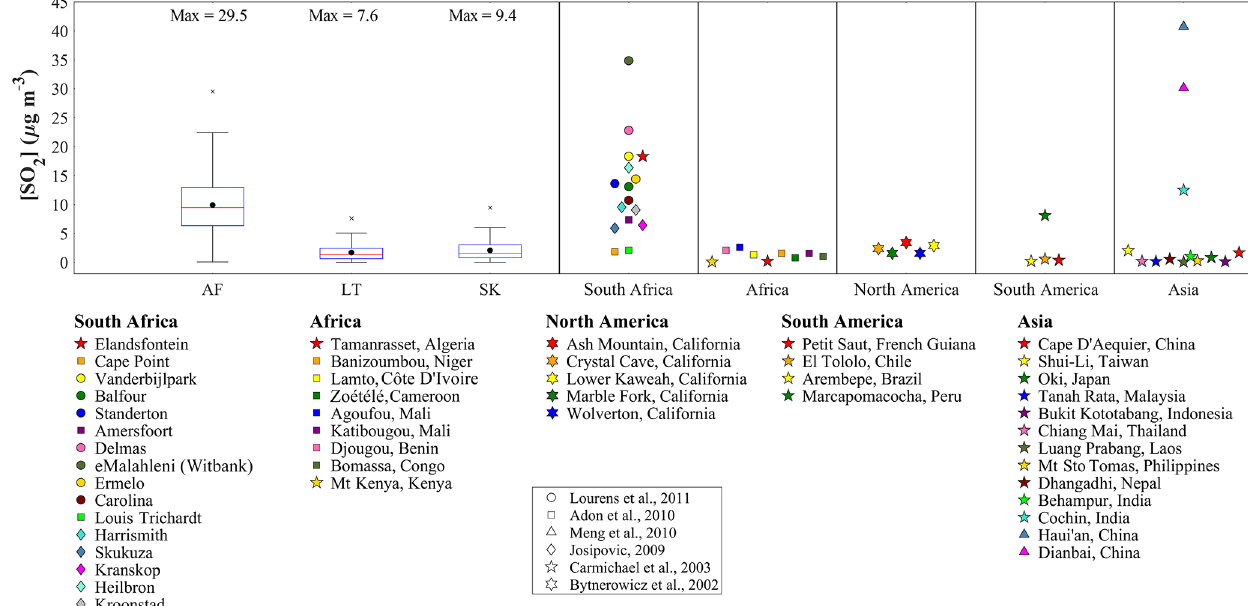
Figure 12. Statistical spread of SO 2 concentrations determined during the entire measuring period at each site compared to mean levels determined with passive samplers elsewhere. The red line of each box represents the median; the top and bottom edges of the box represent the 25th and 75th percentiles, respectively; the whiskers are ± 2 . 7 σ (99.3% coverage if the data have a normal distribution); and the black dots represent the average concentrations.